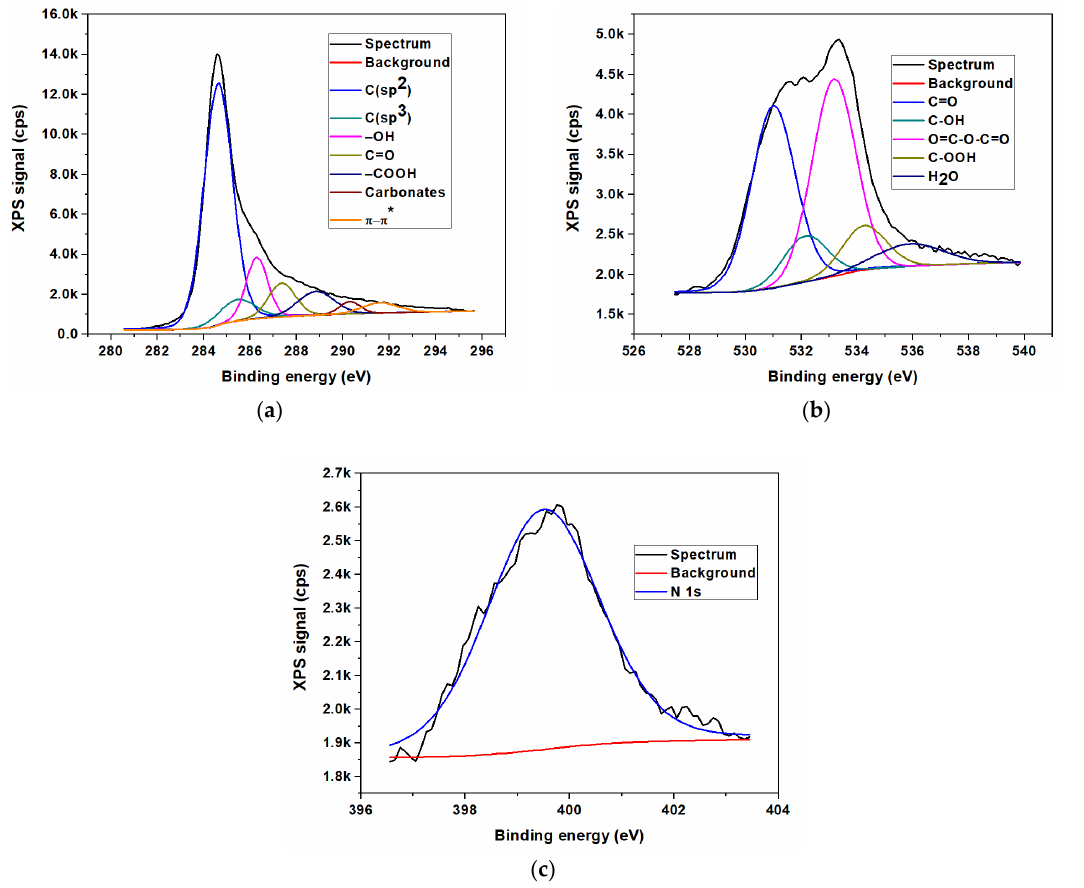
Figure 5. XPS high resolution spectra for nitrogen-doped graphene oxide synthesized using urea (N/GO_U); ( a ) Carbon (C1s); ( b ) Oxygen (O1s); ( c ) Nitrogen